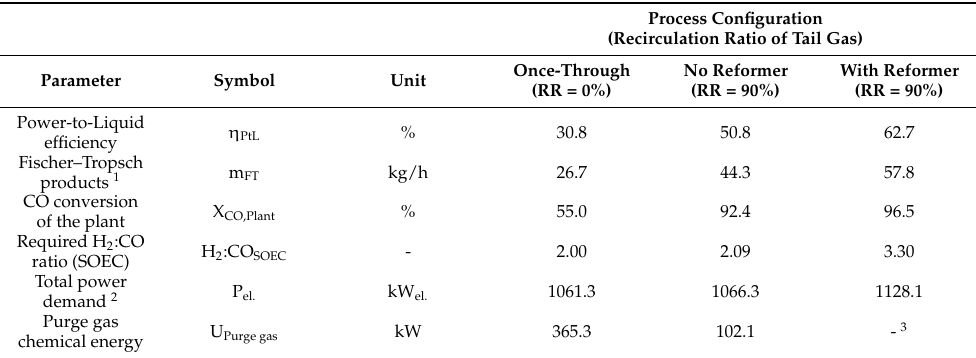
Table 8. Obtained key performance indicators of the Power-to-Liquid plant for the respective process configurations with and without a tail gas